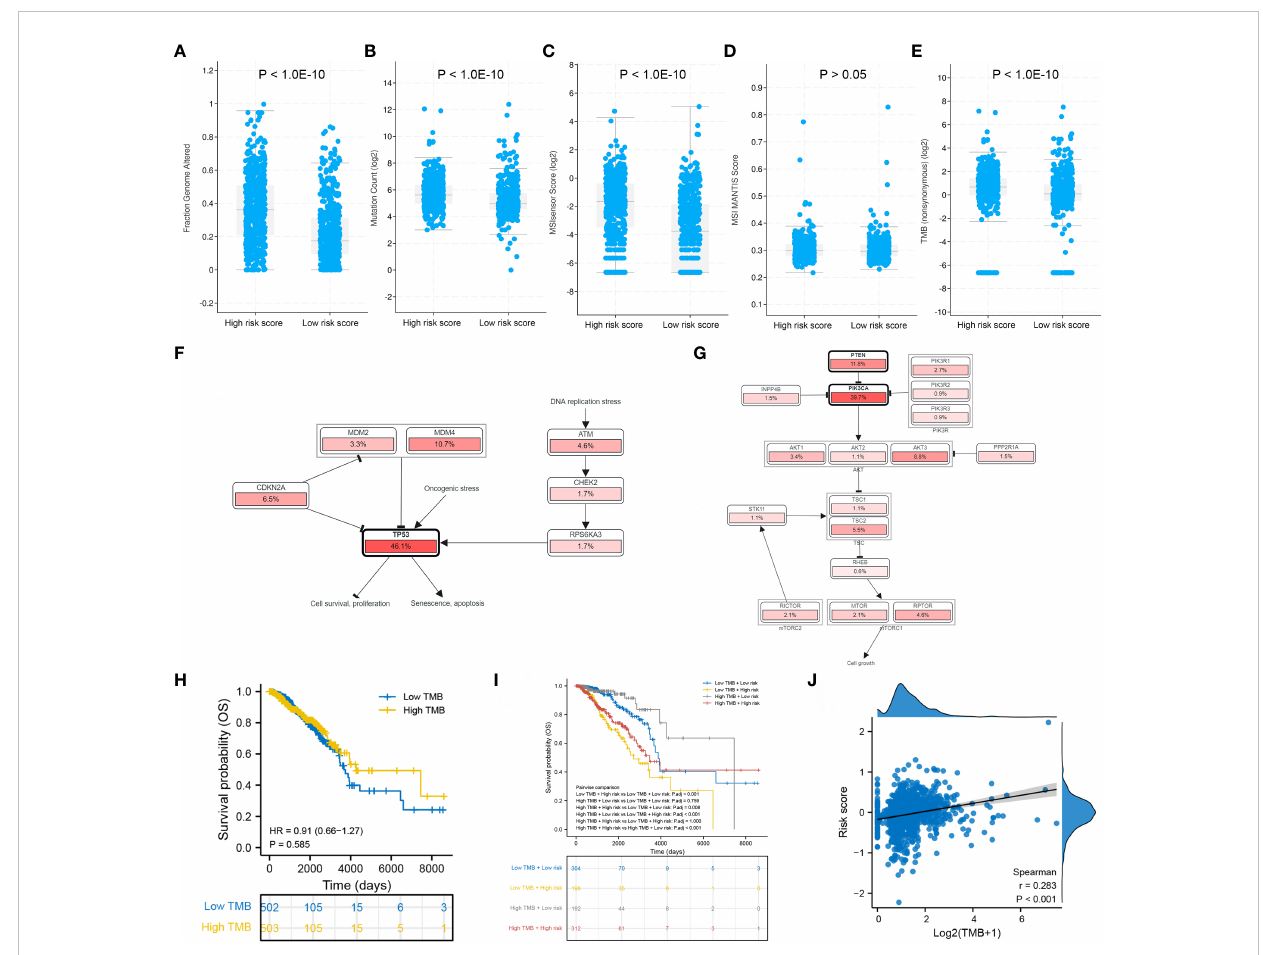
FIGURE 9 Mutation differences between the low- and high-risk groups. Differences in (A) fraction of genome altered, (B) gene mutation count, (C) MSIsensor score, (D) MSI MANTIS score and (E) TMB between the two risk groups. Dominant signaling pathways in the (F) high-risk group and (G) low-risk group. (H) Survival analysis between the low- and high-TMB groups. (I) Survival analysis integrating the risk score and TMB. (J) Correlation between the risk score and